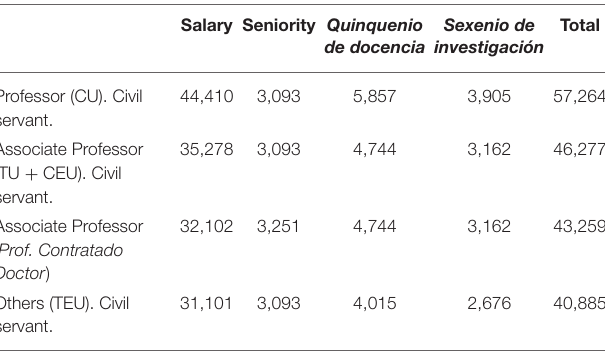
TABLE 3 | Tenured professors’ gross annual salaries (euros) calculated for 15 years of seniority with all bonuses earned.